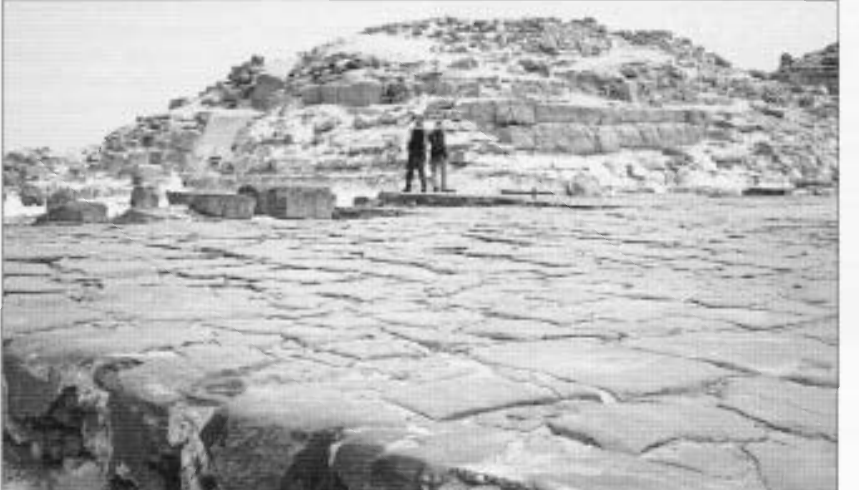
Figure 2 Basalt floor (foreground) of Khufu 's mortuary temple (Fourth Dynasty).